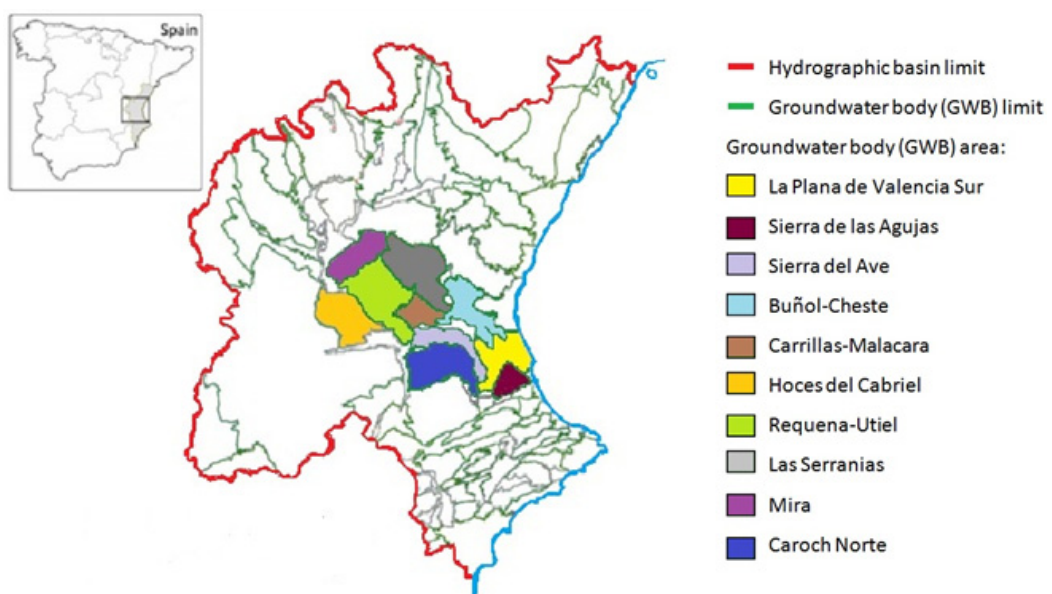
Figure 1. The groundwater bodies considered in the